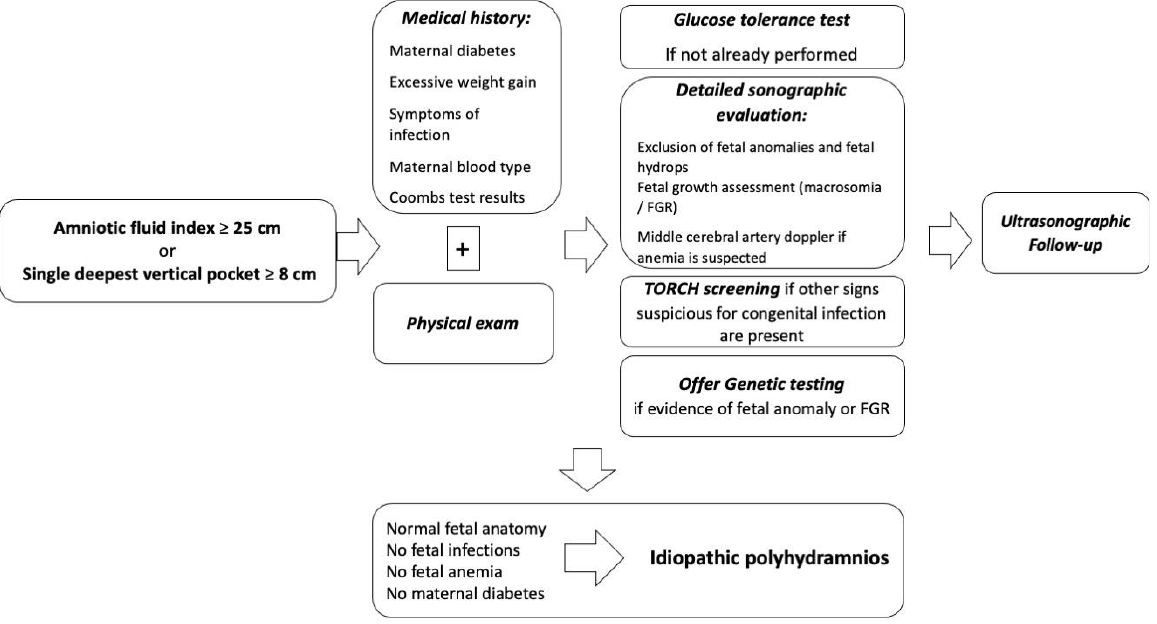
Figure 4. Diagnostic workup for cases of polyhydramnios.